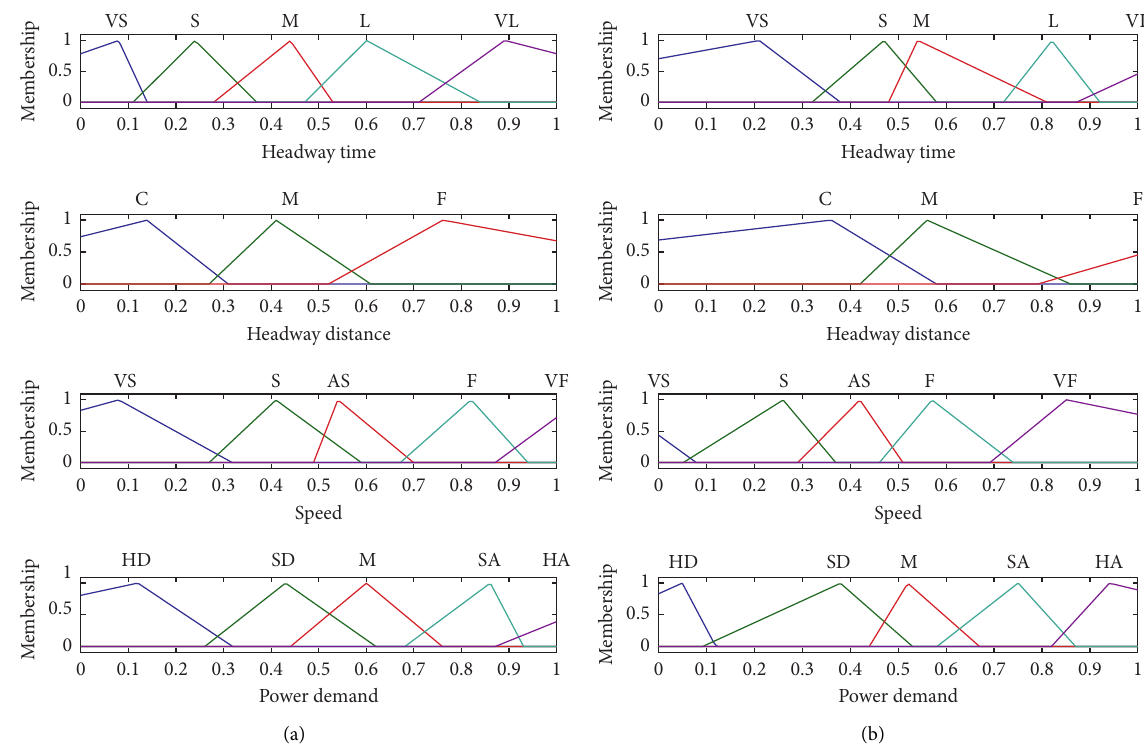
Figure 9: Calibrated membership functions. (a) Aggressive model. (b) Defensive model.